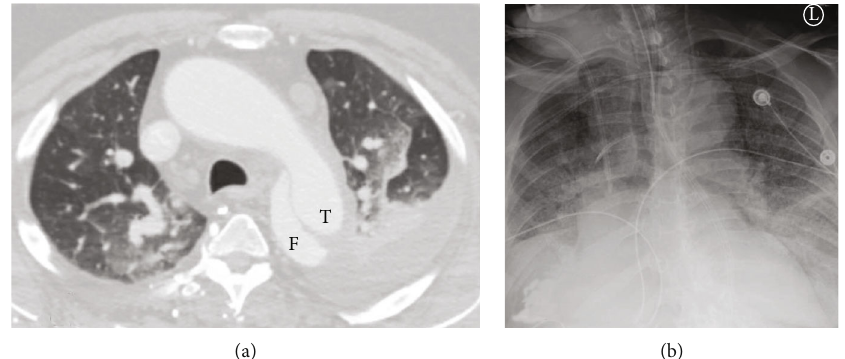
Figure 1: (a) CTA of chest (February 16, 2020) with Type B aortic dissection (T: true lumen; F: false lumen). (b) Chest X-ray (February 28, 2020) with bilateral pulmonary opacities and pleural e ff